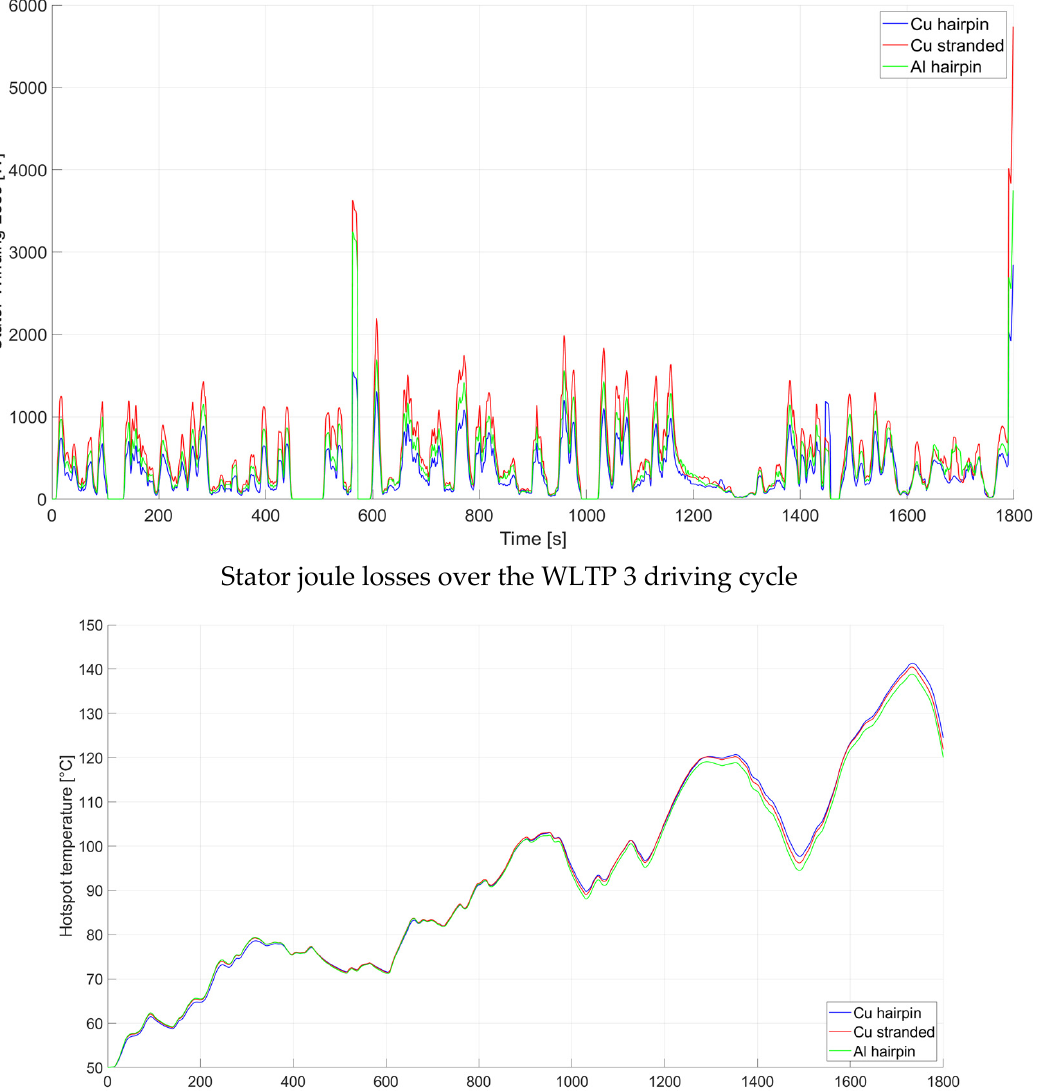
Table 7. Results for the WLTP class 3 drive cycle.